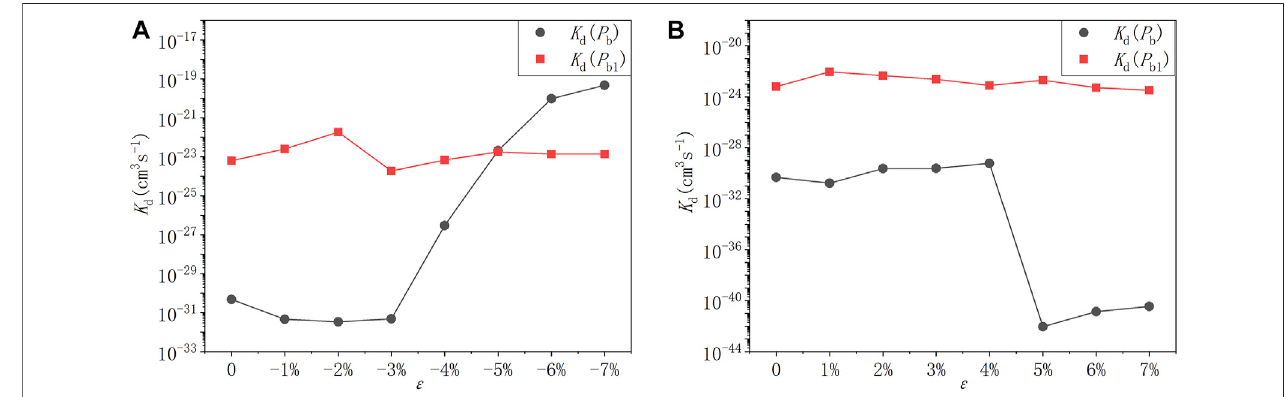
FIGURE 10 | The depassivation reaction rate curves of P b and P b1 defects under (A) compressive strains and (B) tensile strains at room temperature (300K).